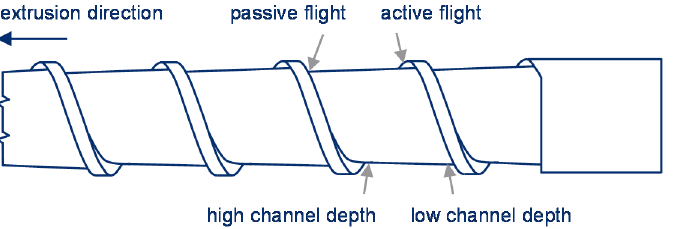
Figure 3. Conical screw channel for improved conveying adapted with permission from [8]. 2021 Rahal.